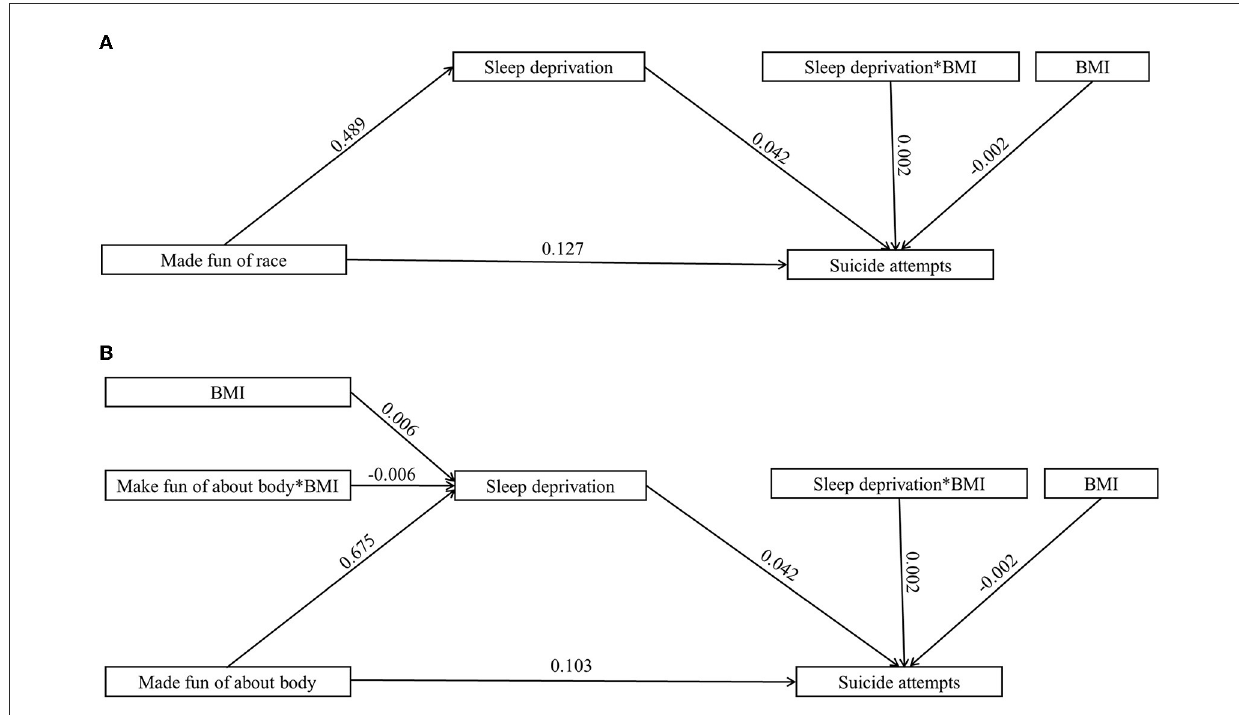
FIGURE3 The moderated mediation model with different types of bullying (partial mediating effects) ( n = 121,869). (A) Made fun of race. (B) Made fun of about